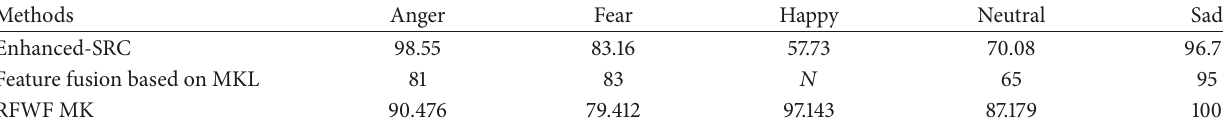
Table 4: Comparison on SER accuracies (%) of 5 emotions in Berlin database.